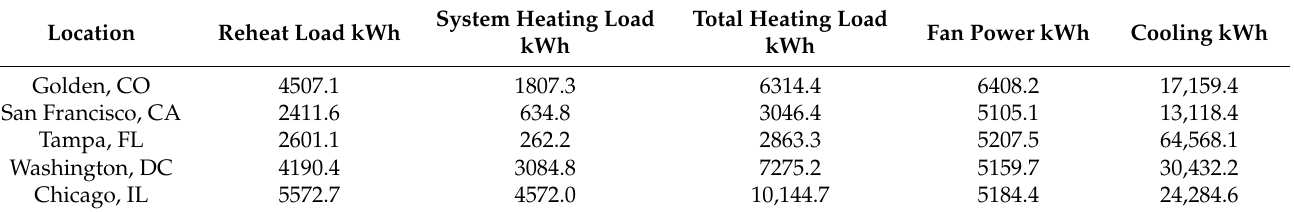
Table 2. Annual energy fan consumption and loads for baseline (Strategy